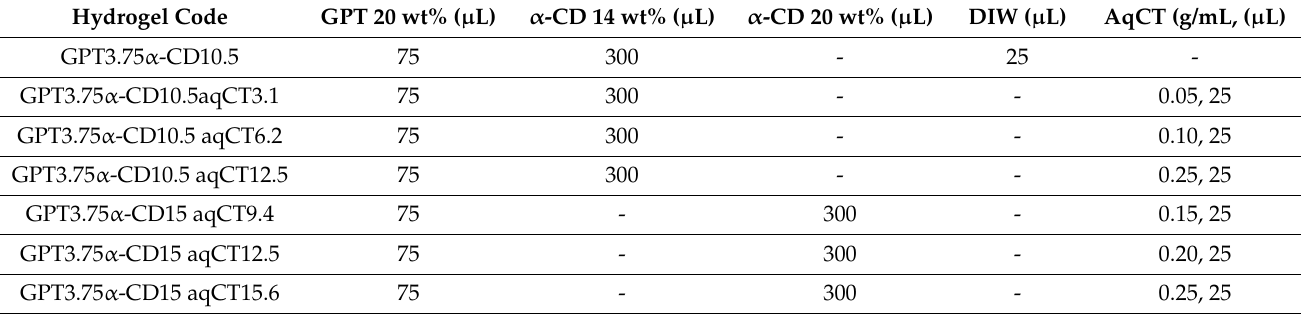
Table 3. Hydrogel